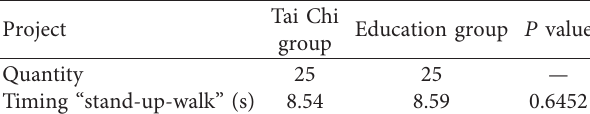
Table 1: Comparison of timing “stand-up” before